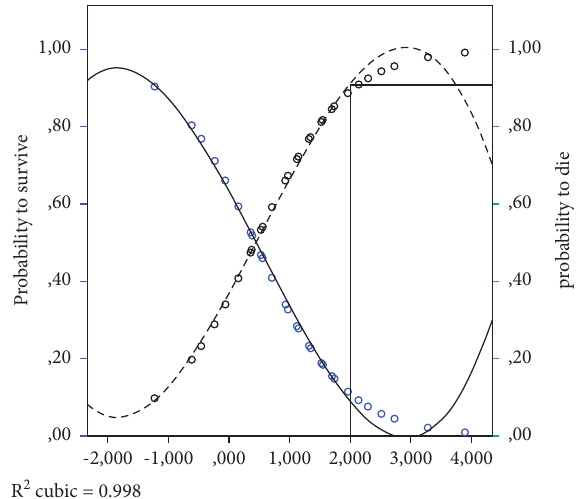
Figure 1: Probability of surviving, (a) or dying, (b) by the Dis- criminant